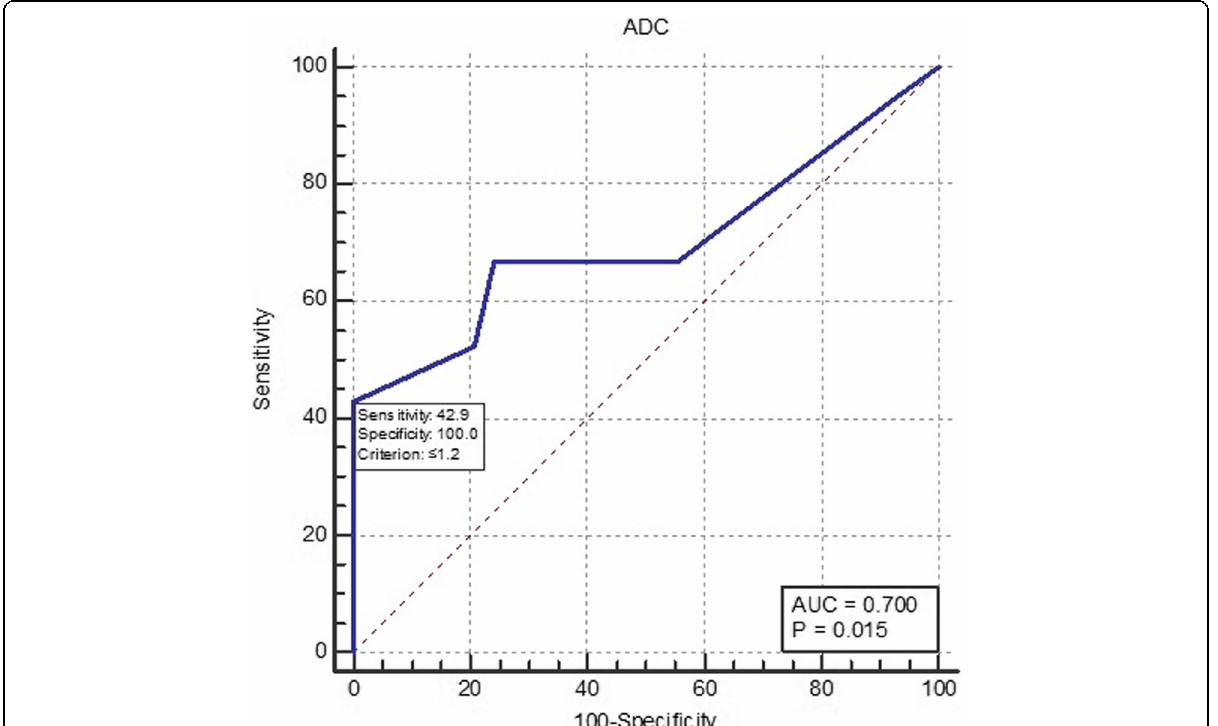
Fig. 6 ROC curve shows the performance of ADC for differentiating low-stage from high-stage RCC (selection of 1.2 × 10 − 3 mm 2 /s as a cutoff point of ADC value revealed an AUC of 0.6, sensitivity of 42.9 %, and specificity of 100